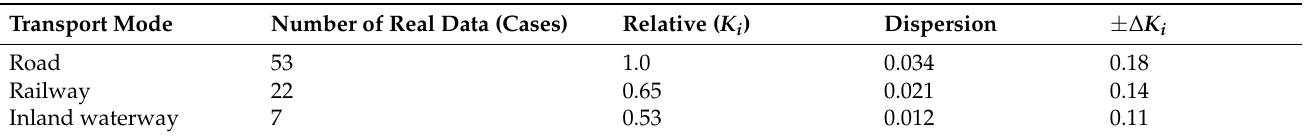
Table 3. Relative ( ∆ K i ) for the selected case study based on collected real